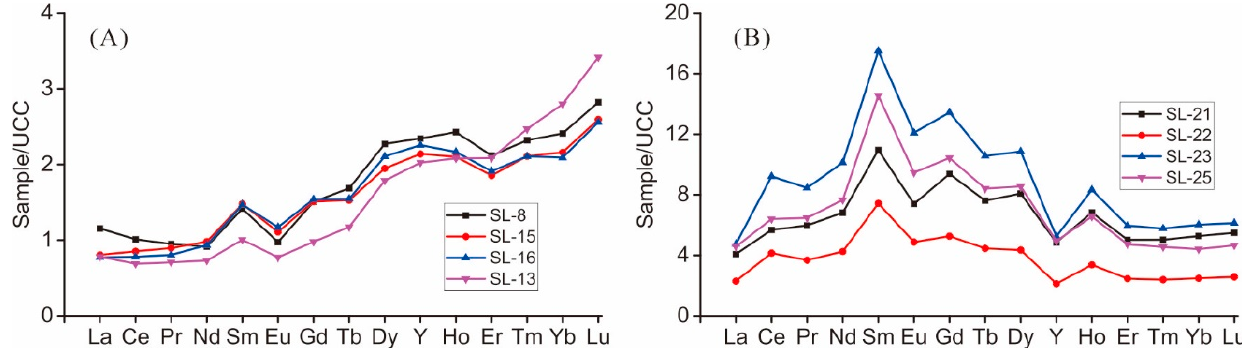
Figure 7. Distribution patterns of rare earth elements and yttrium (REY) in the studied coals ( A , B ). REY are normalized to the upper continental crust [52].